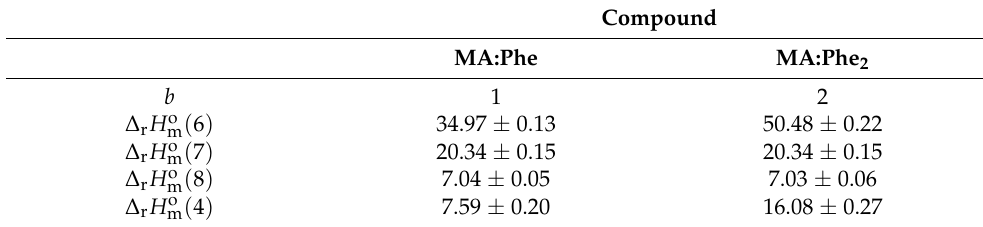
Table 3. Enthalpies of solution and reaction at 298.15 K. Data in kJ · mol − 1